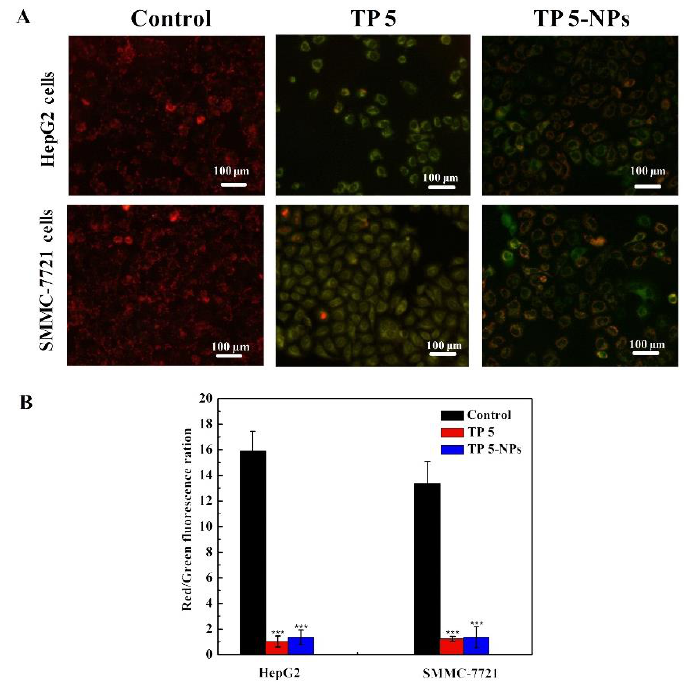
Figure 7. Effect of free TP 5 or TP 5 -NPs on cellular mitochondria. The HepG2 and SMMC-7721 cells were treated with TP 5 or TP 5 -NPs for 12 h, the level of mitochondrial depolarization showed by fluorescence. ( A ) Merge images treated with different formulations; ( B ) The numerical data of red/green fluorescence ratio. The presented data are mean ± SD. *** p < 0.001 relative to control. The majority of cells presented strong green fluorescence when treated with free TP 5 or TP 5 -NPs. the JC-1 polymer/monomer fluorescence ratios of cells treated with TP 5 and TP 5 -NPs were both lower than those of controls. Abbreviations: TP 5 ; thiophene derivatives; TP 5 -NPs, TP 5 -loaded nanoparticles.